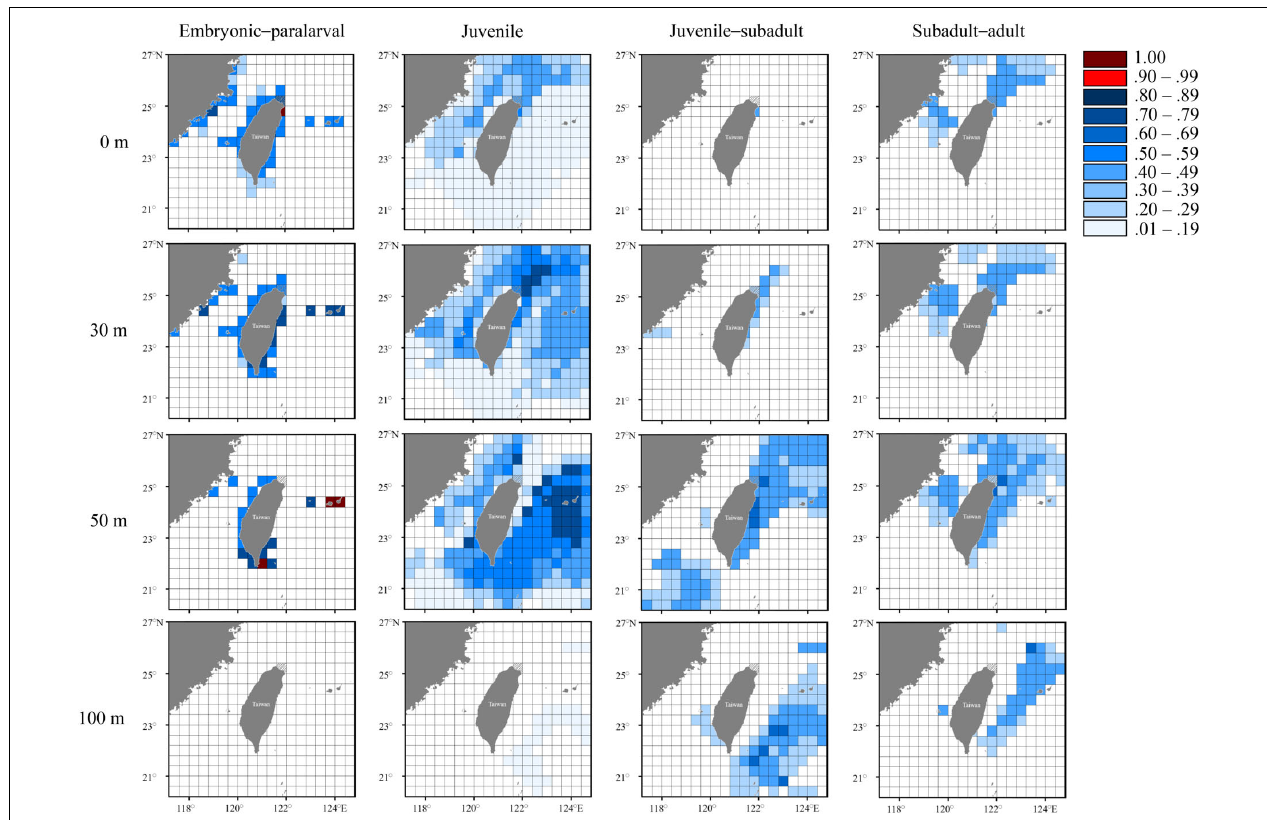
FIGURE 7 | Probability distribution based on experienced temperatures in S. lessoniana individuals in the spring group at each life stages. The legend indicates the probability value of occurrence.